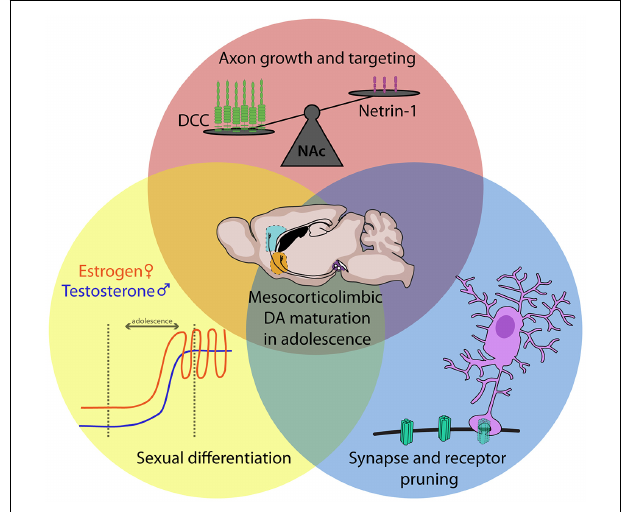
FIGURE 6 | Dopamine as a “plasticity system”: convergent mechanistic processes shape adolescent mesocorticolimbic dopamine maturation in response to environmental cues. In this review, we identify three mechanistic processes that contribute to the adolescent establishment of DA pathways. We comment on how each of these processes may link experiential factors to alterations in DA